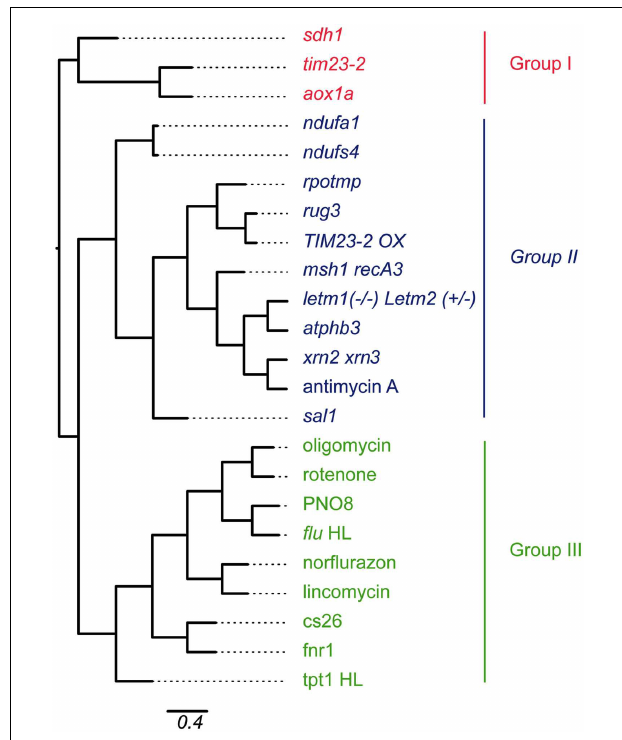
FIGURE 2 | Hierarchical clustering of microarray experiments relating to mitochondrial and chloroplast perturbations. Gene expression values of probe sets that were significantly altered in at least four of 13 experiments relating to mitochondrial or chloroplast perturbations were hierarchically clustered using Pearson correlation coefficient. Branch lengths indicate relative distance in expression patterns as indicated by the scale bar (percentage identity). Abbreviations: Cell cul, cell culture; Chloro Pert, chloroplast perturbation; Mito pert, mitochondrial